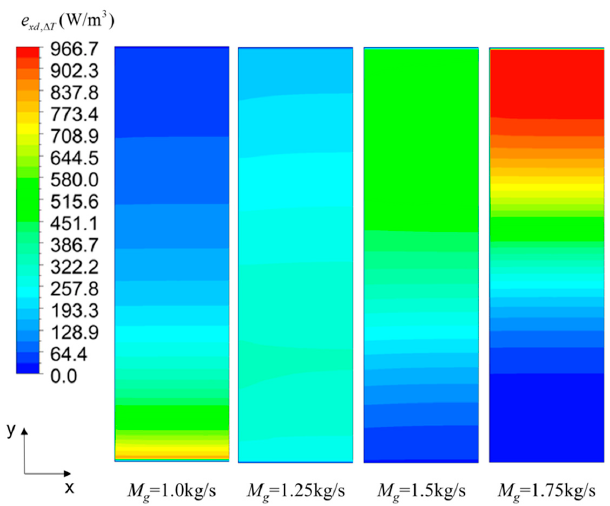
Figure 7. Influence of the air flow rate on the pressure drop.